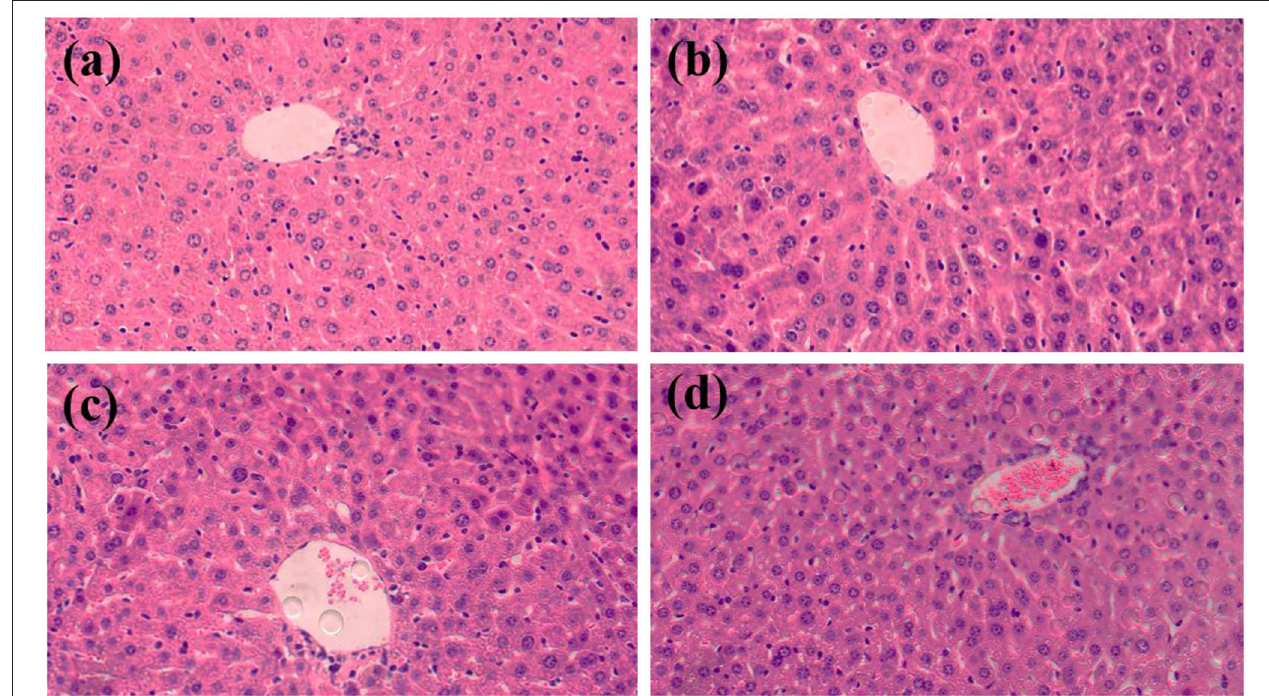
FIGURE 2 | Histopathological analysis of liver (HE, 400 × ). (A) CG, (B) LG, (C) MG, and (D) HG.